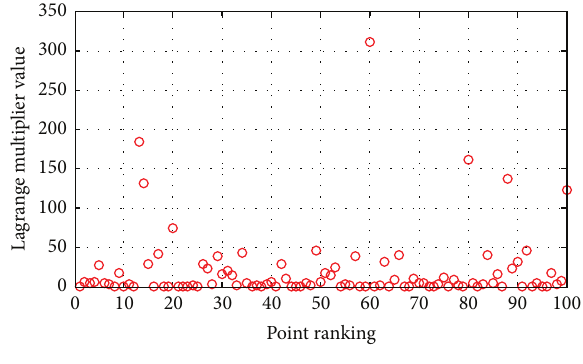
Figure 1: Lagrange multiplier value.